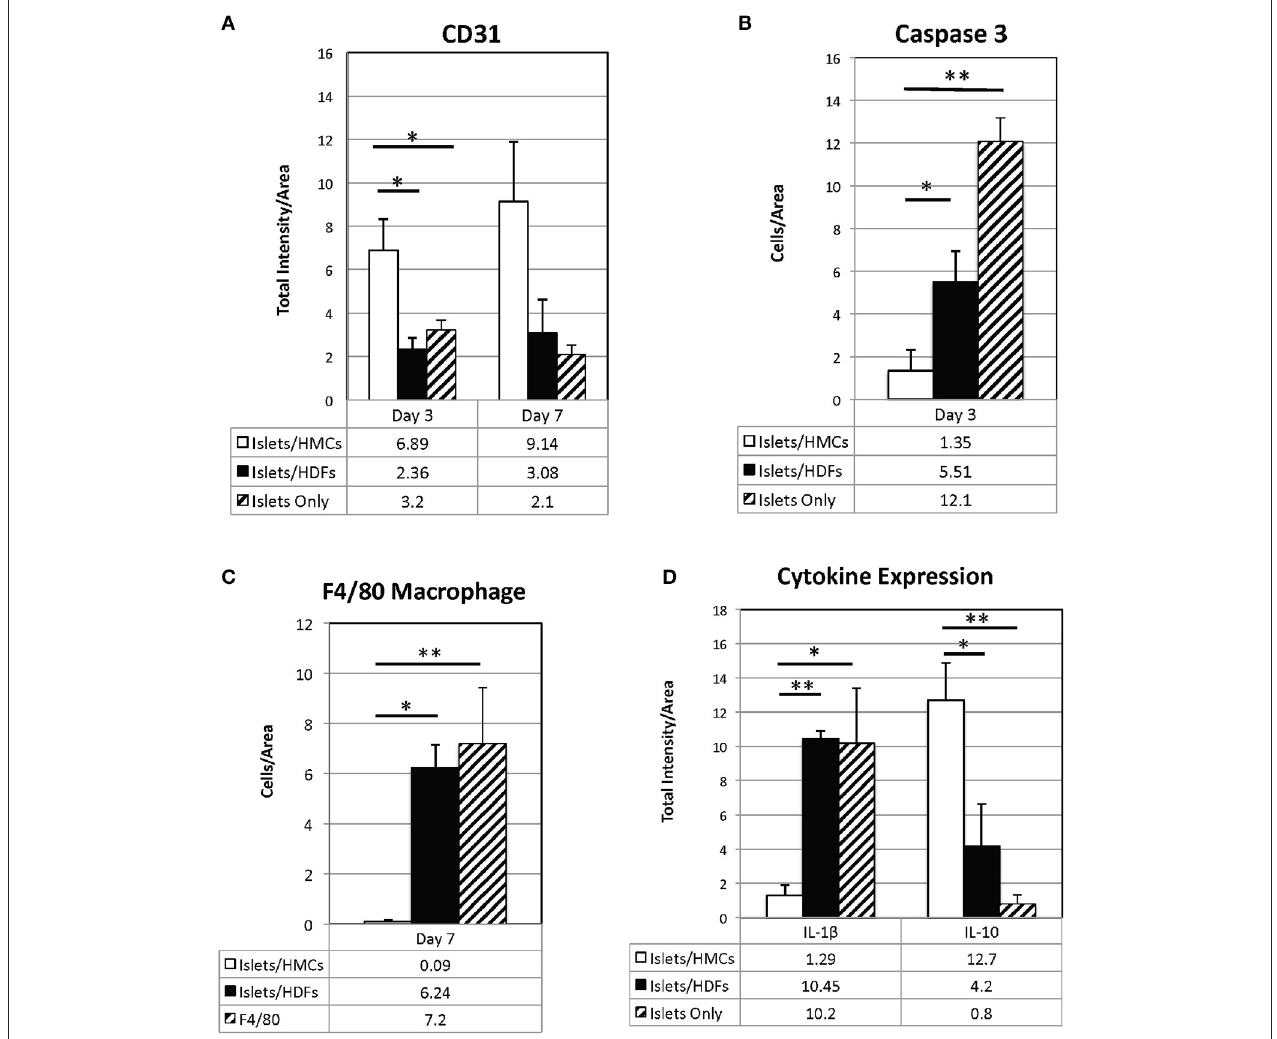
FIGURE 6 | Quantification of immunostaining for CD31 (A) , Il-1 β , and Il-10 (D) is expressed as total intensity/pixel area. Caspase 3 (B) and F4/80 (C) are expressed as cells/ relative pixel area. Graphs show means ± SEM. 3 to 6 graft sections from different animals were used in calculating each value. A one-way ANOVA (parametric) or Kruskal-Wallis test was performed with a Tukey’s multiple comparisons post-test as appropriate to determine statistical significance. * p < 0.05, ** p < 0.01.